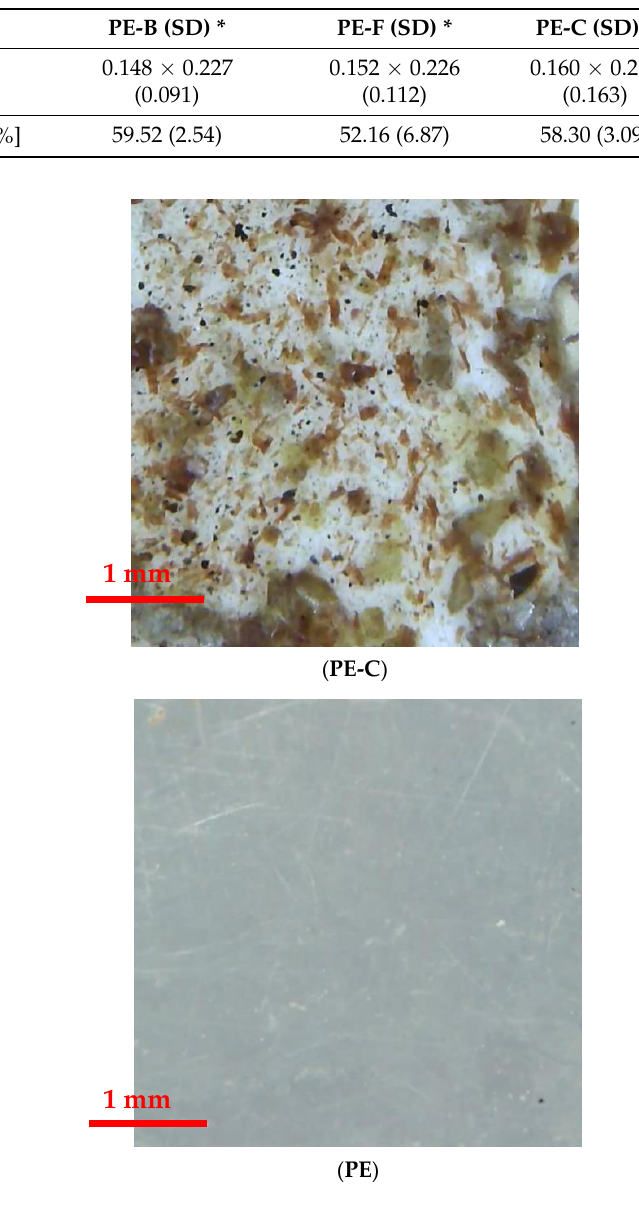
Figure 6. Microscopic photos of PE – pomace based membranes.